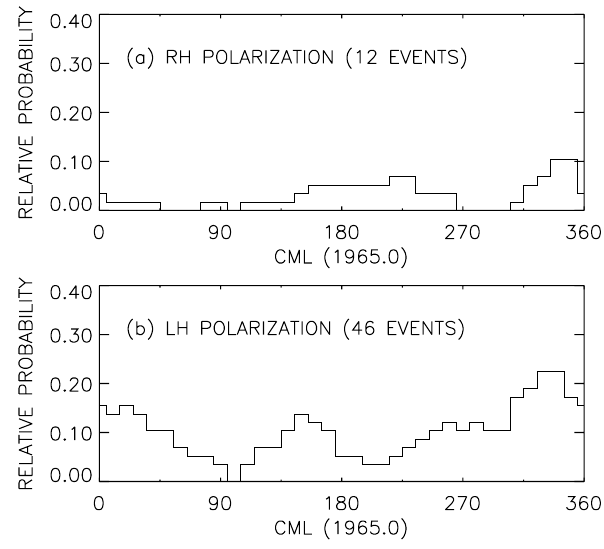
Fig. 7. Relative occurrence probability of the HOM observed by Ulysses for (a) RH polarization and (b) LH